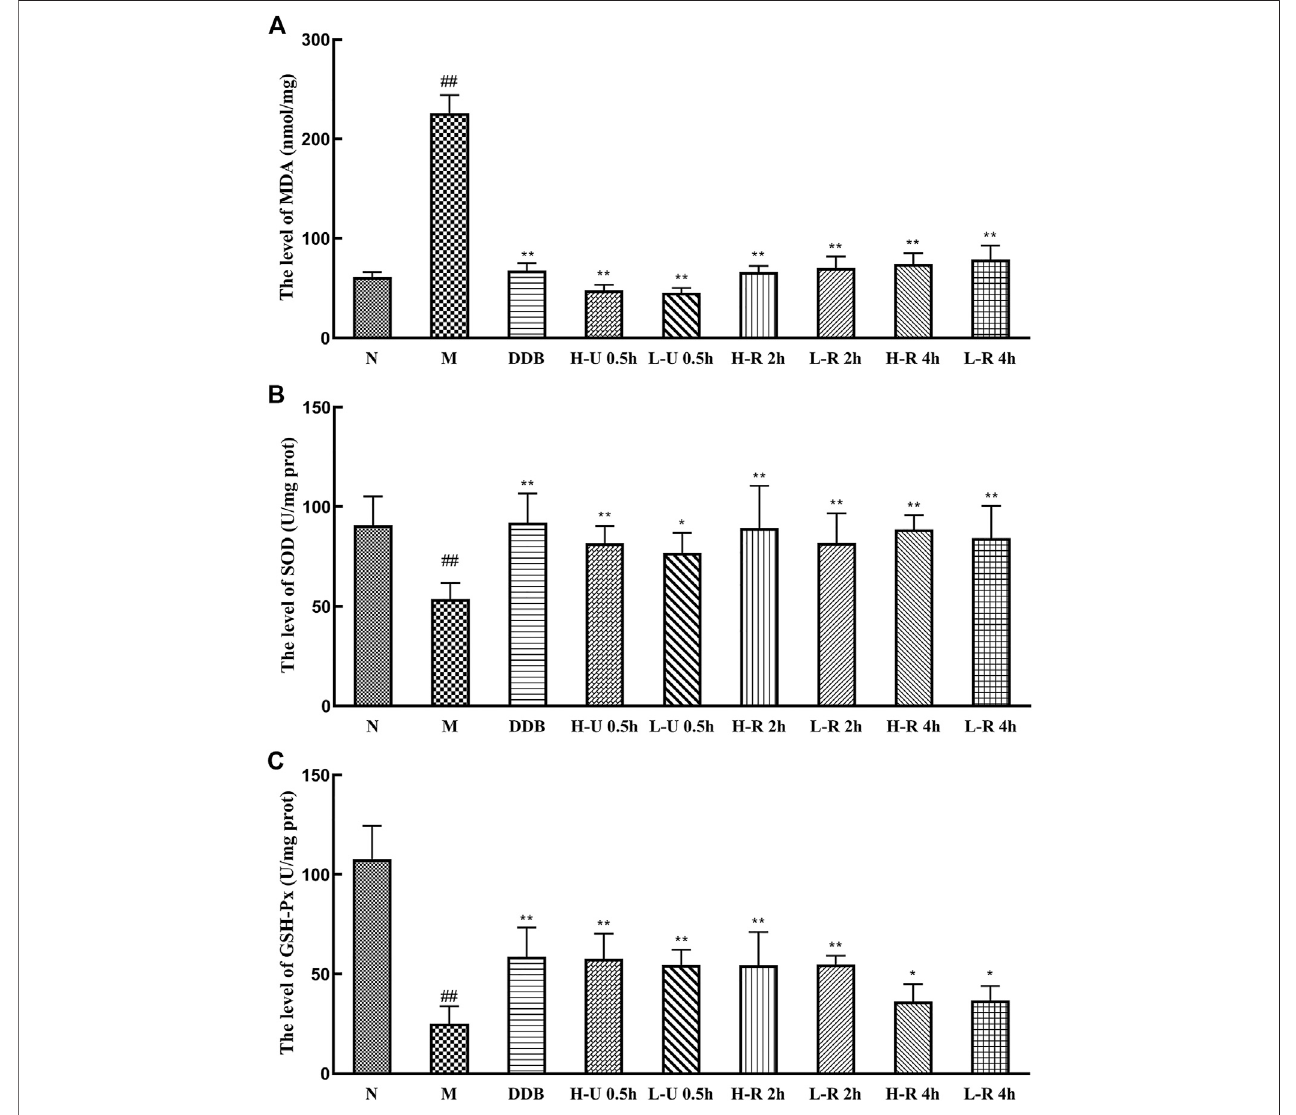
FIGURE5| Comparison ofliverlevelsofMDA (A) ,SOD (B) andGSH-Px (C) ( x ± s, n (cid:1) 6).Compared withgroupN, # p < 0.05, ## p < 0.01; compared withgroupM, * p < 0.05, ** p < 0.01.